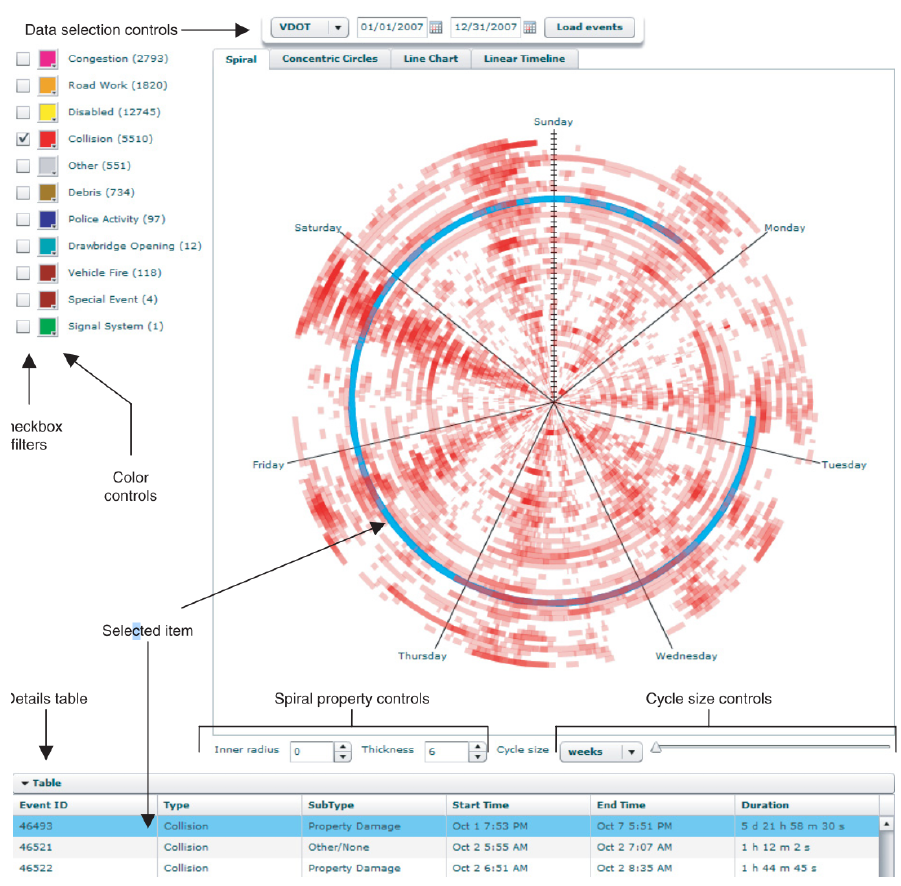
Figure 24. The Spiral Graphs tool for temporal transportation data